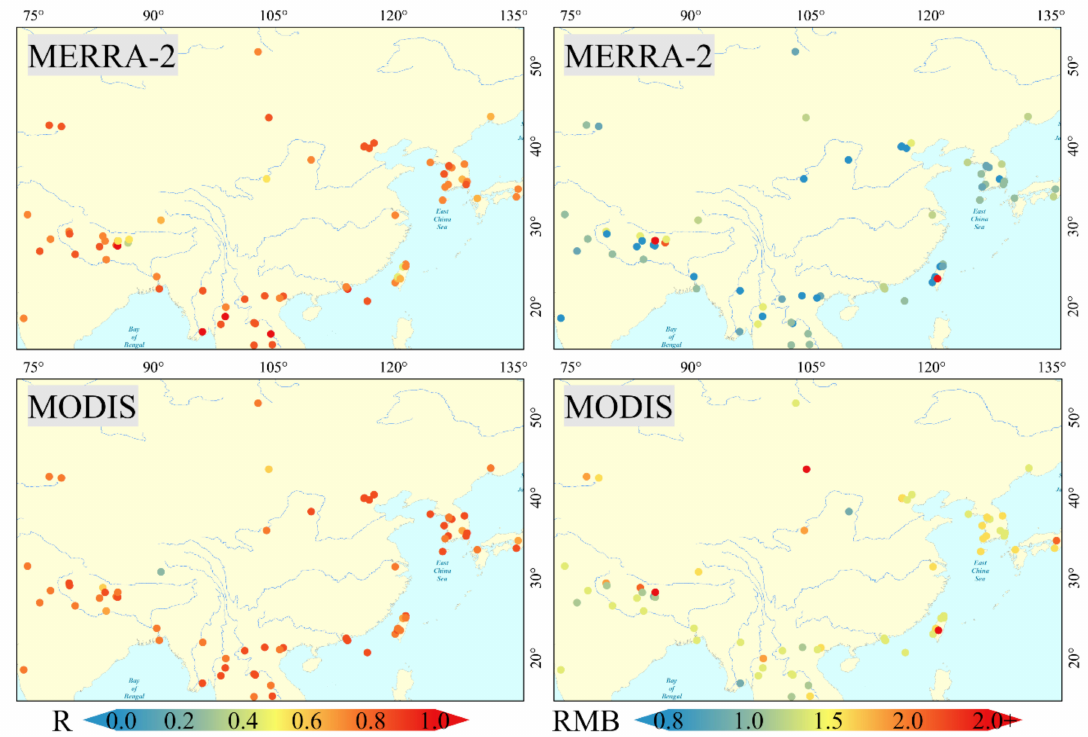
Figure 4. The R and RMB values of MERRA-2 and MODIS against AERONET AOD under site